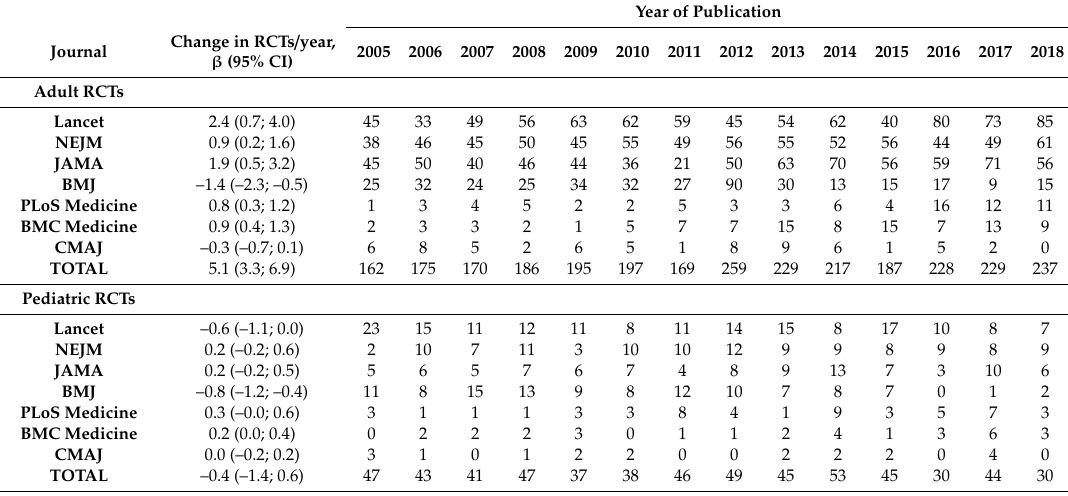
Table 3. Characteristics of a stratified random sample of pediatric and adult RCTs in seven general medical journals, 2005–2018.